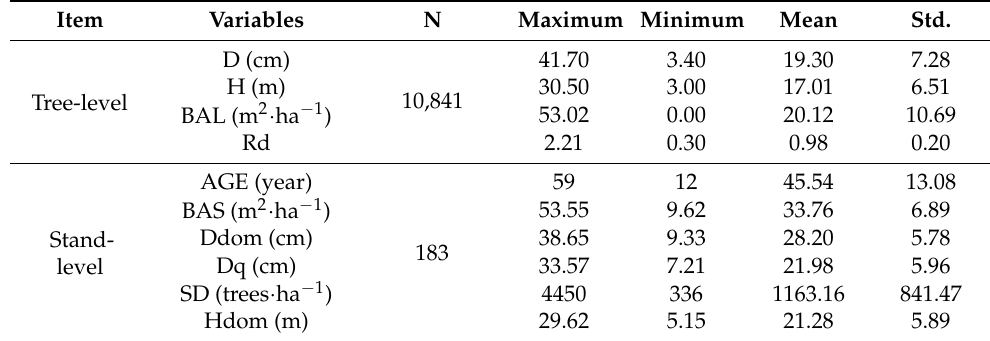
Table 1. Descriptive statistics of variables for the sample plots and sample trees.